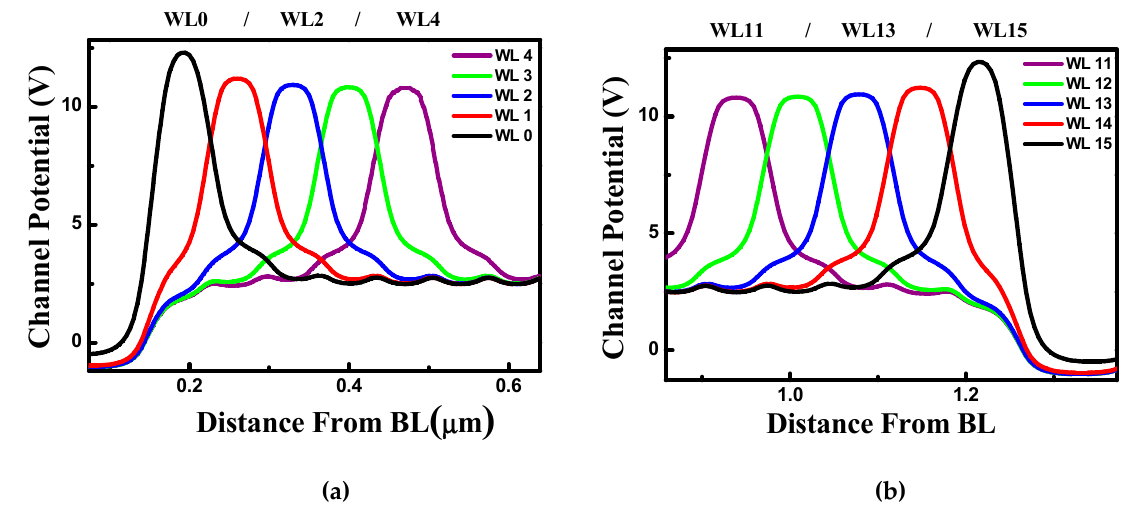
Figure 2. NLSB in WL ( a ) NLSB occurring in the bottom cells (WL0 through WL4), and ( b ) NLSB occurring in the top cells (WL11 through WL15).